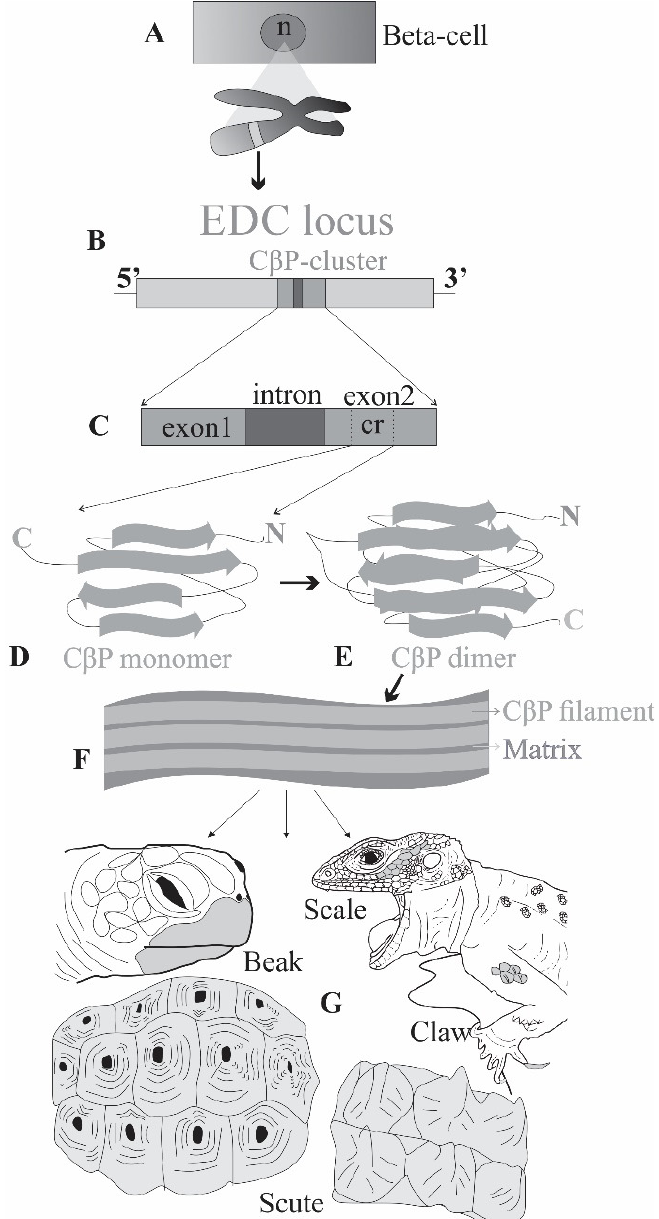
Figure 2. The formation of CBP ( A ) Chromosomal EDC locus within the nucleus (n) of a beta-cell. ( B ) The CBP cluster within the EDC locus. ( C ) Closer look to CBP cluster showing one intron and two exons of which only the second one has a coding region (cr). ( D , E ) Monomer and dimer of CBP, respectively, showing beta-sheet conformation. ( F ) CBP filaments covered and inter-filamentous matrix. ( G ) Different horny epidermal appendages made of CBPs, such as beak, scale, claw and scutes (The figure is modified from [20], Reprinted/adapted with permission from Ref. [20]. 2016,